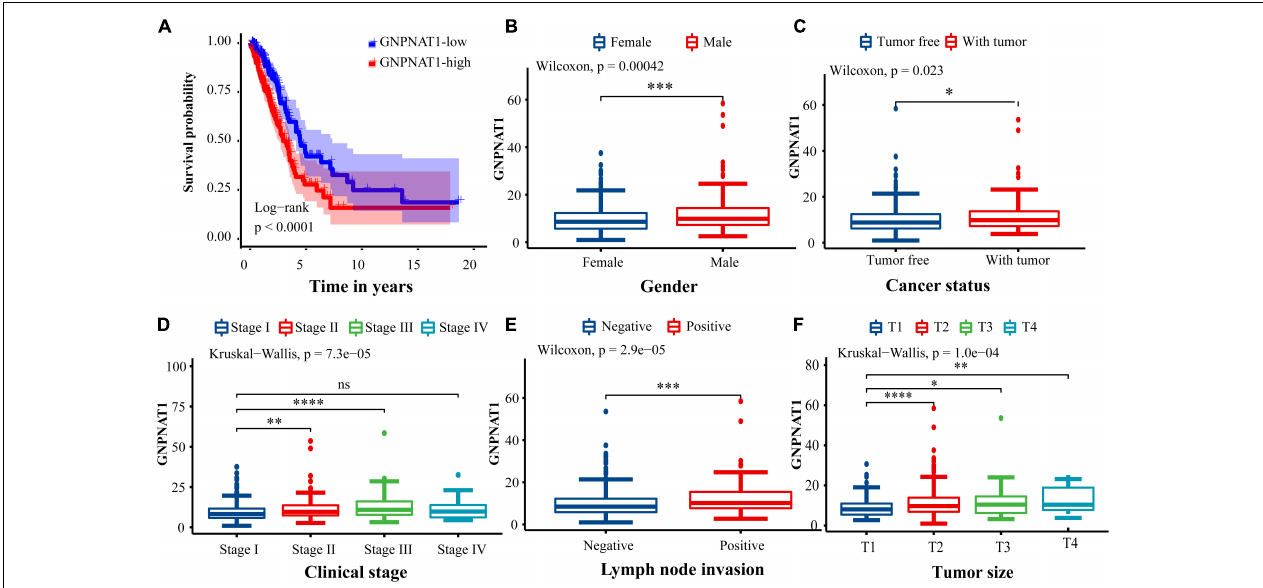
FIGURE 3 | Association of GNPNAT1 expression with clinicopathologic characteristics. (A) The survival curve between low and high expression of GNPNAT1 in LUAD. The correlation between GNPNAT1 and clinicopathologic variables involved in gender (B) , cancer status (C) , clinical stage (D) , lymph node metastasis status (E) , and tumor size (F) . * P < 0.05, ** P < 0.01, *** P < 0.001, and **** P < 0.0001, ns: insignificant. TABLE 3 | The Cox regression of clinicopathologic characteristics with the overall survival in LUAD. Parameters Univariate analysis Multivariate analysis